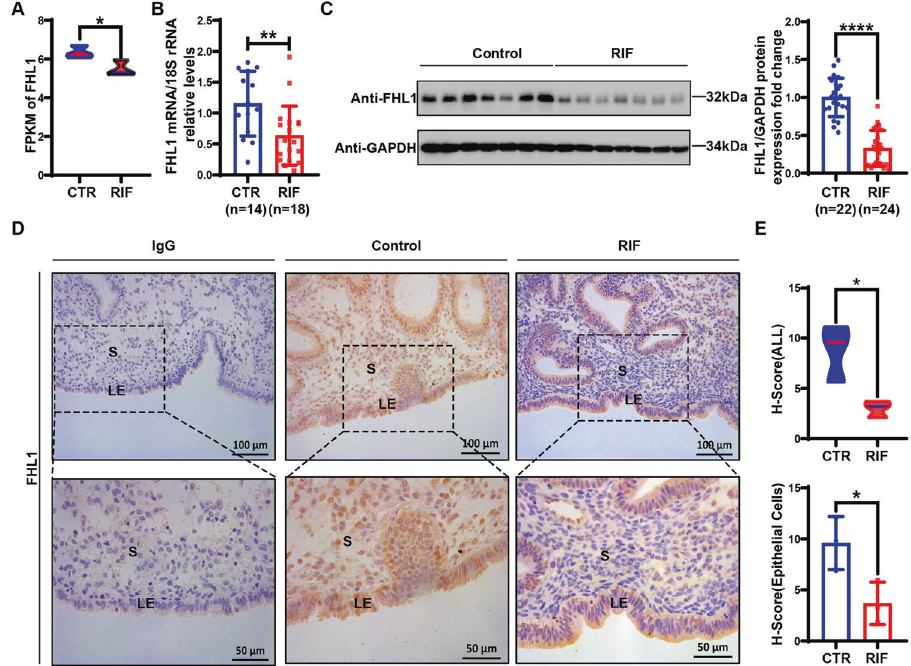
Fig. 1 FHL1 expression is markedly decreased in endometrial cells of RIF patients. A GEO database data (GSE103465) show that FHL1 is expressed in the endometria of women with RIF and fertile controls. B The relative expression of FHL1 mRNA in RIF ( n = 18) and CTR (fertile women, n = 14) human endometrial tissues was measured by qRT – PCR. The 18S gene was used as a loading control. ** P < 0.01, by Student ’ s t test. C Western blot analysis to detect FHL1 in RIF ( n = 24) and CTR (fertile woman, n = 22) human endometrial tissues. Normalization was performed with the GAPDH protein as a housekeeping protein. *** P < 0.001, by Student ’ s t test. D , E The localization of FHL1 expression in RIF ( n = 3) and CTR (fertile woman, n = 3) human endometria was detected by immunohistochemistry. The total expression of FHL1 in RIF and CTR endometria and its expression in epithelial cells were analyzed. IgG was used as a negative control. GE: gland, S: stroma. * P < 0.05, by Student ’ s t test. Scale bar = 50 μ